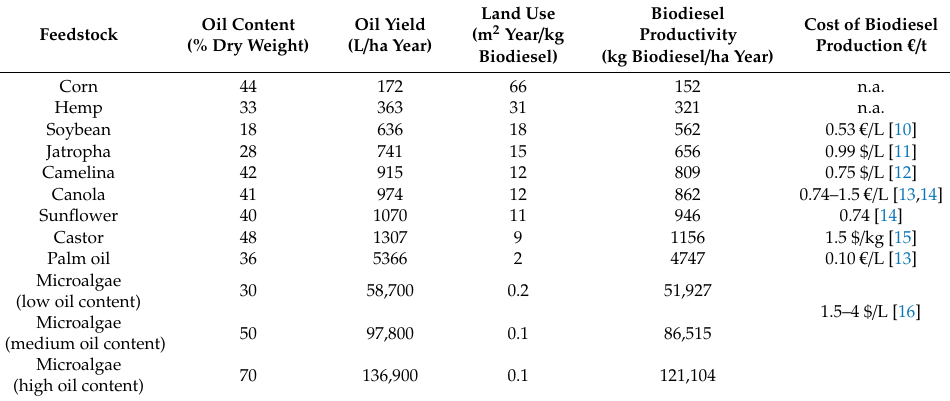
Table 1. Comparison of microalgae with other biodiesel [9].